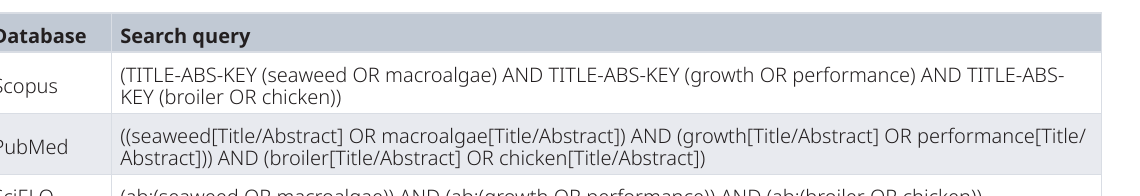
Table 2. The search query in Scopus, PubMed, and SciELO